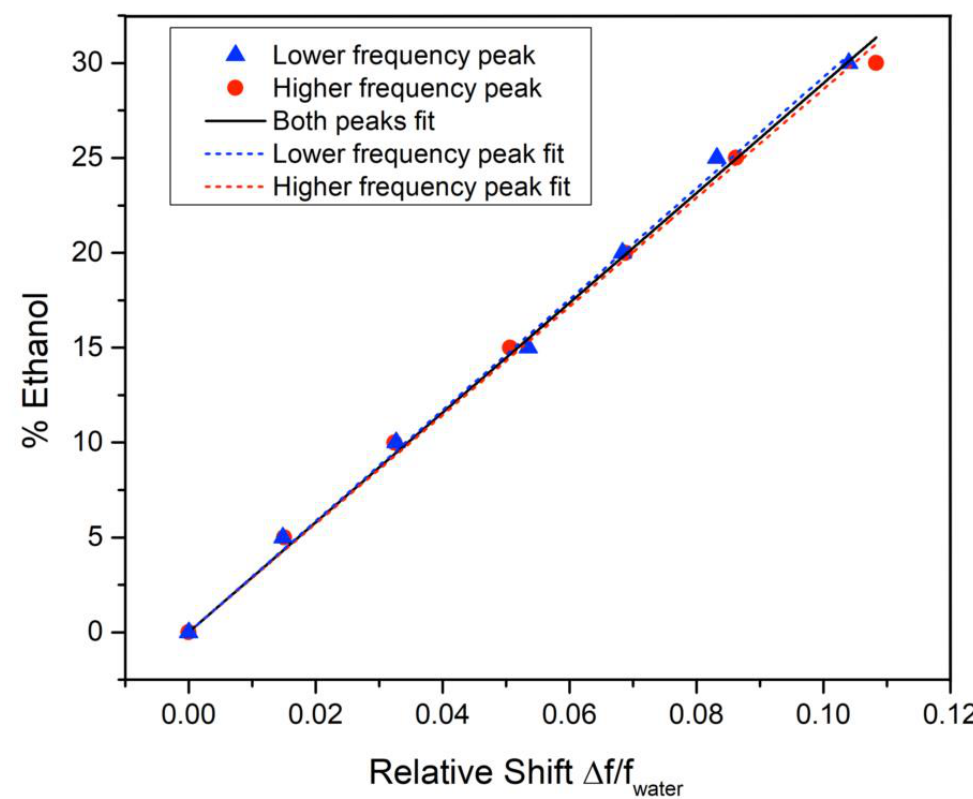
Figure 6. Linear fitting of the ethanol percentage as a function of the relative frequency shift ∆ f/f water .